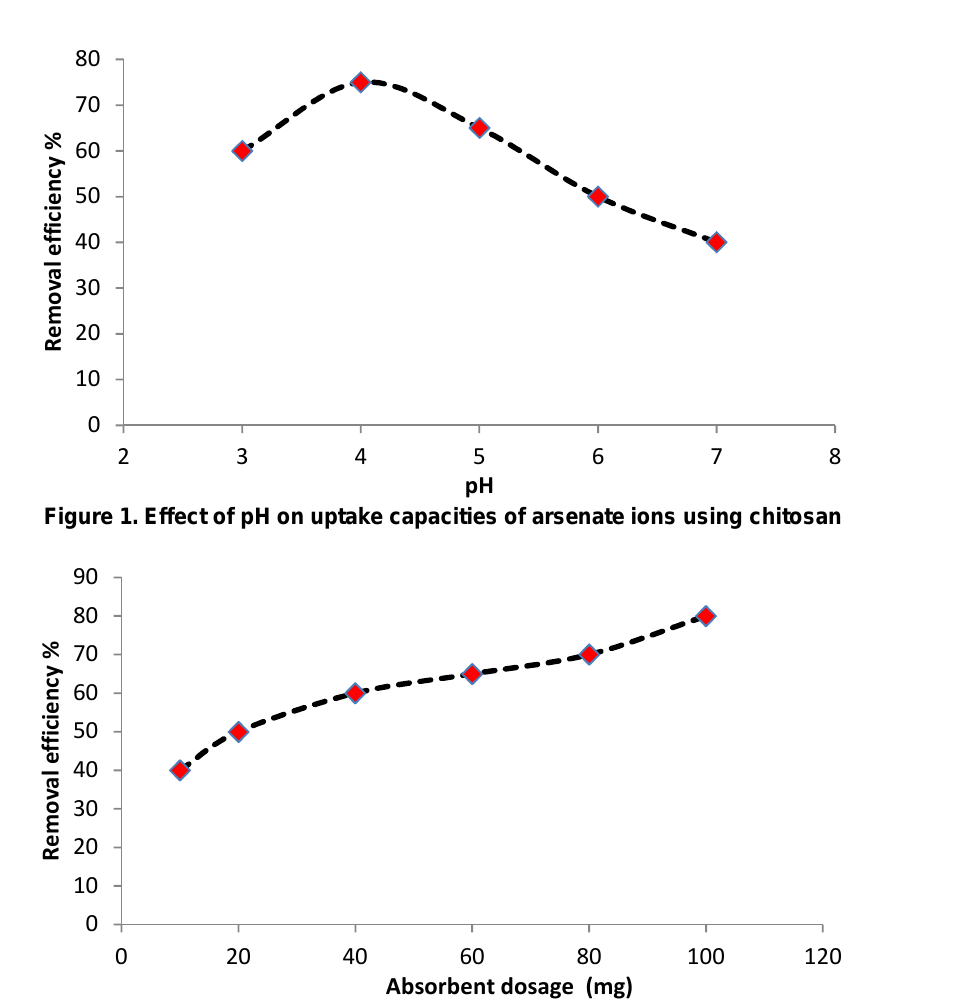
Figure 2. Effect of biosorbent dosage on biosorption of arsenate